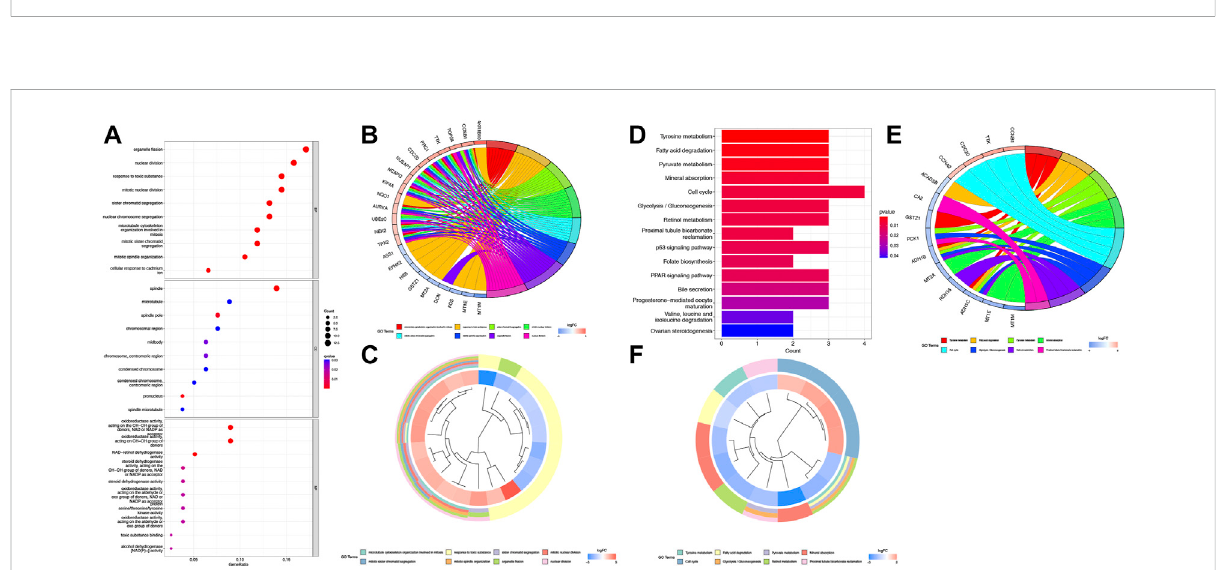
FIGURE 2 Function analysisbasedon theDEGs (A) Heatmap ofGO analysis. (B) Circos plotofGO termsbasedon DEGs. (C) Cluster pro fi leranalysis ofthe GObasedonDEGs. (D) BarplotofKEGGtermsbasedonDEGs. (E) CircosplotofKEGGtermsbasedonDEGs. (F) Clusterpro fi leranalysisoftheKEGG based on